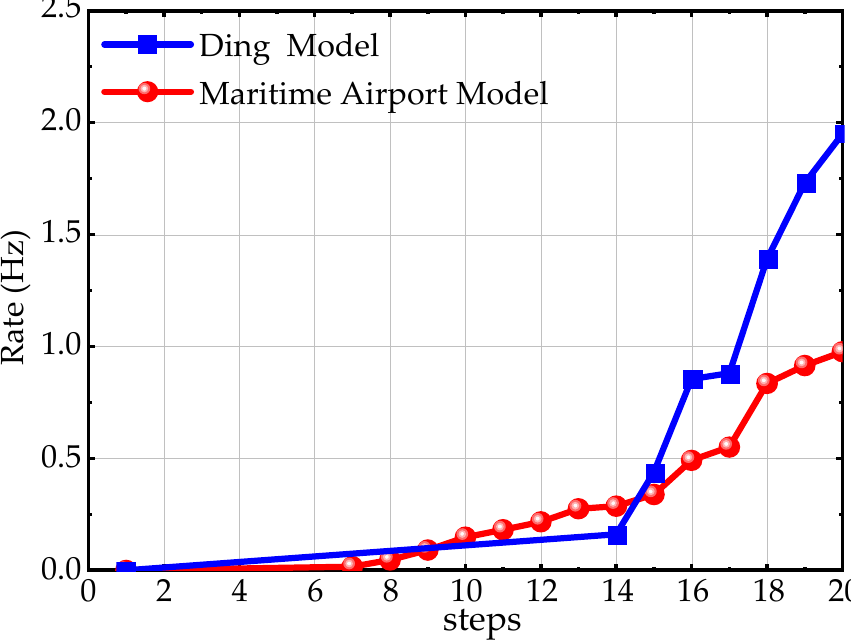
Figure 5. Frequency comparison of offshore airport models.